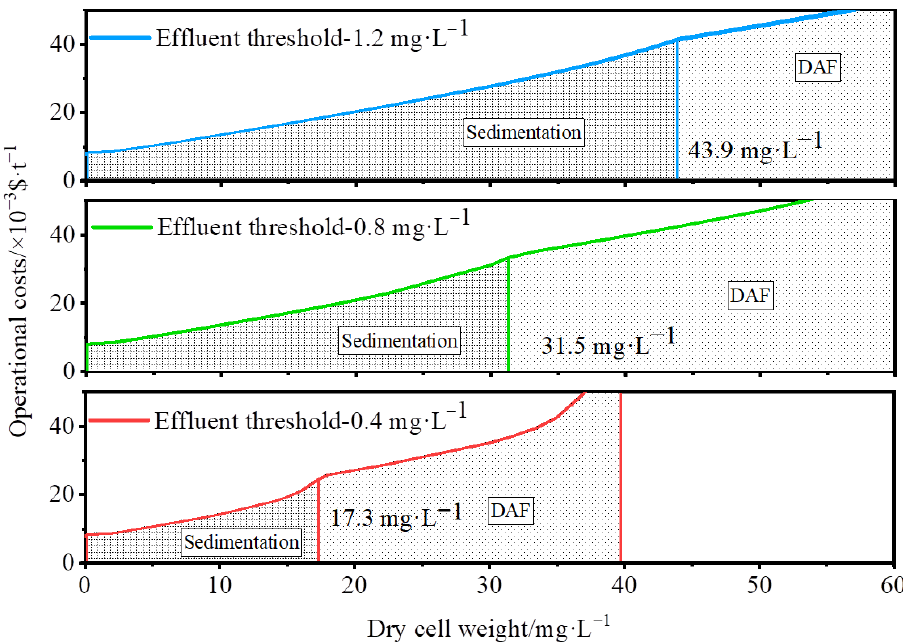
Figure 6. Relationship between the total operating costs and algae concentrations in the raw water at different effluent thresholds of the sand filter; 17.3 mg ∙ L − 1 , 31.5 mg ∙ L − 1 , and 43.9 mg ∙ L − 1 are the concentrations at which DAF is selected instead of sedimentation.